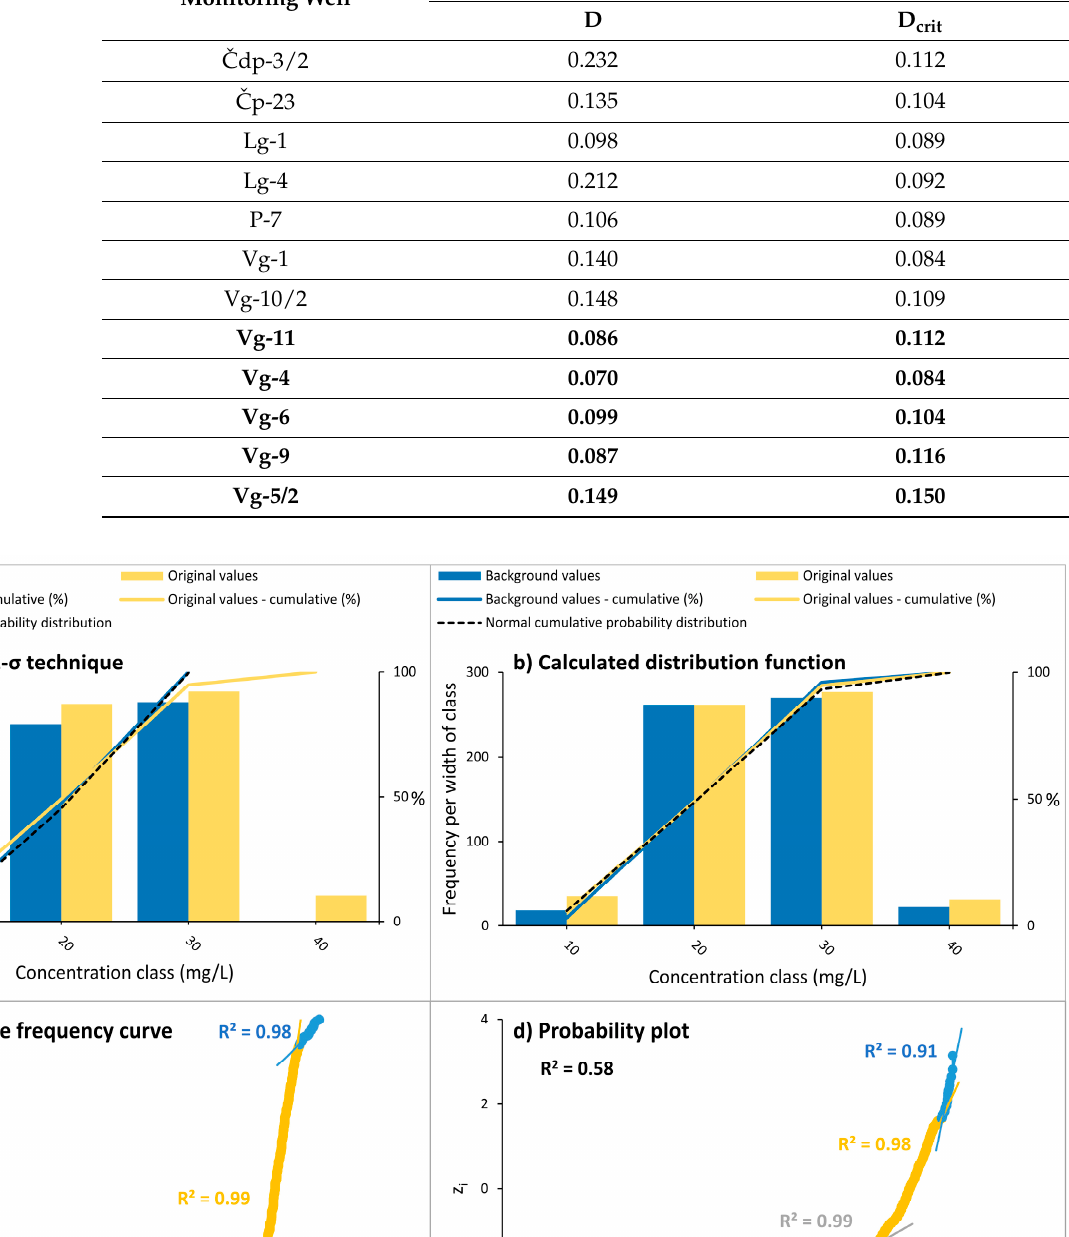
Table 2. Lilliefors test of normality. Normally distributed data are bolded (D < D crit ). Monitoring Well